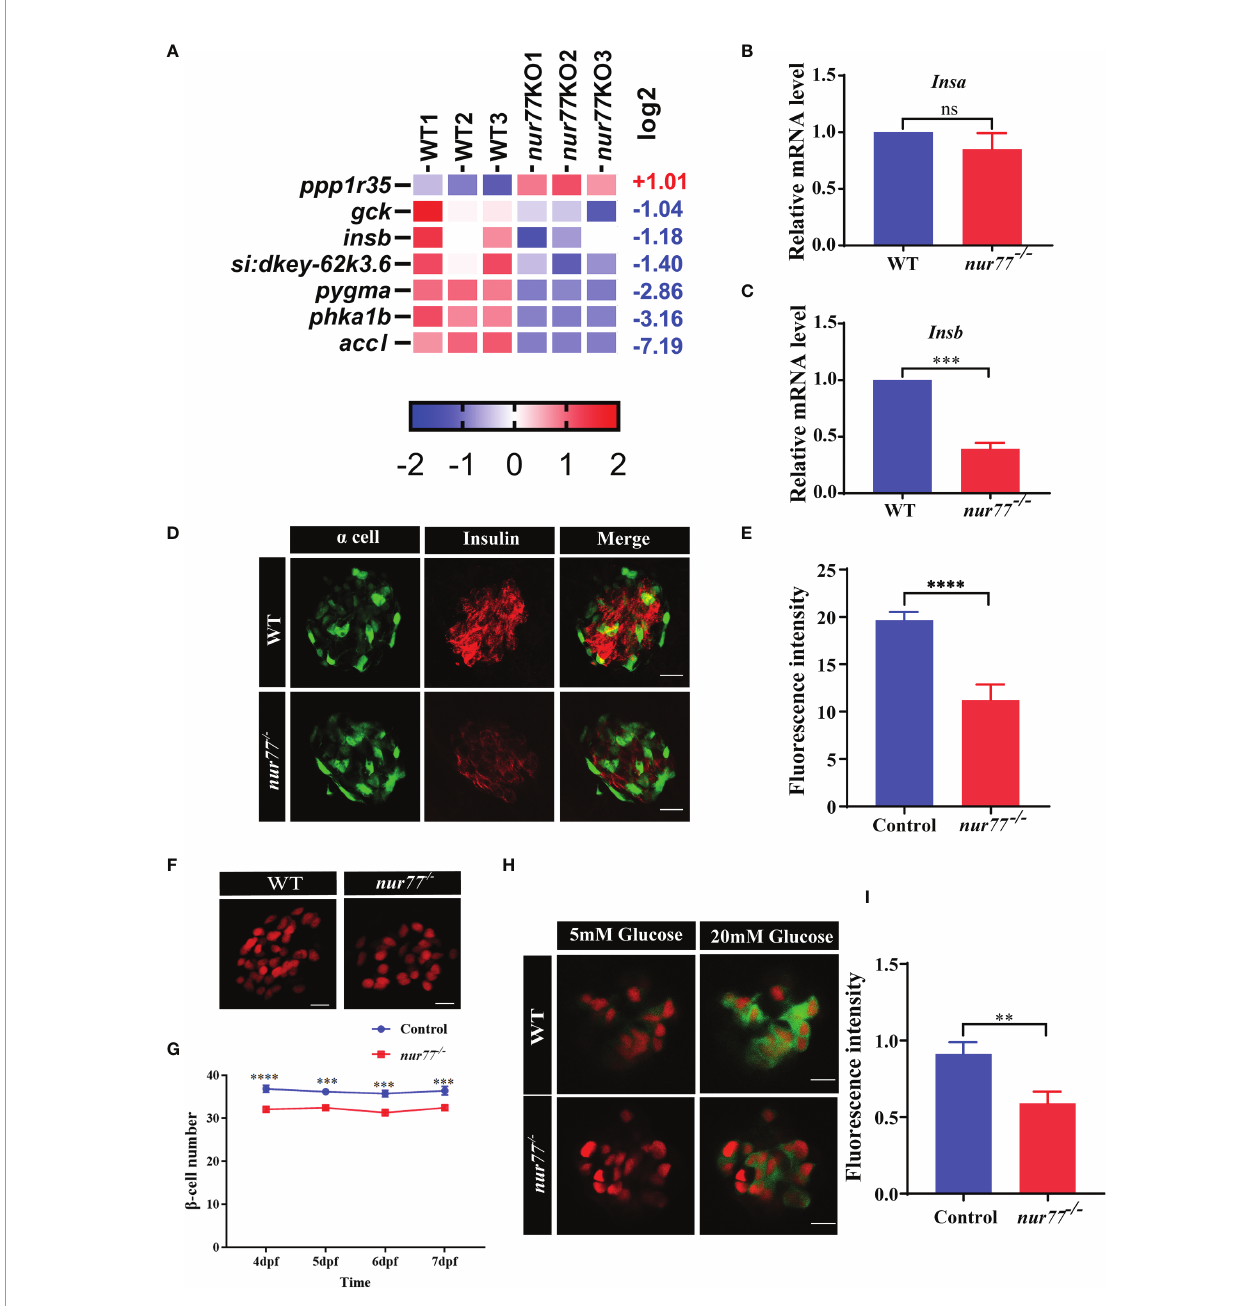
FIGURE 6 | Nur77 regulates insulin secretion and b -cell number in zebra fi sh larvae. (A) Heatmaps of transcripts in insulin signaling pathway. Colors represent high (red), low (blue), or average (white) expression values based on Z-score-normalized fragments per kilobase per million mapped read (FPKM) values for each gene. (B, C) The validation of the expression levels of insulin genes by qRT-PCR analysis in WT and nur77 − / − zebra fi sh larvae, (B) insa ( n = 3), (C) and insb ( n = 3). (D, E) The insulin contents in WT and nur77 − / − zebra fi sh larvae. (D) Representative images of the fl uorescence of a cell and b cell from control and nur77 − / − ; a cells are indicated by the green fl uorescence with Tg(gcg:eGFP) , b cell are indicated with red fl uorescence by immunostaining with insulin antibody. (E) Quanti fi cation of b -cell fl uorescence intensity from control and nur77 − / − . The number of larvae ( n = 12~18). (F, G) The number of pancreatic b cells in Tg(Ins:H2BmCherry) and nur77 − / − ;Tg (Ins:H2BmCherry) zebra fi sh larvae. (F) Representative images of the b -cell (red) number in Tg(Ins:H2BmCherry) and nur77 − / − ;Tg(Ins:H2BmCherry) at 6 dpf. (G) Quanti fi cation of b -cell number in Tg(Ins:H2BmCherry) and nur77 − / − ;Tg(Ins:H2BmCherry) from 4 to 7 dpf zebra fi sh larvae ( n = 19~50). (H, I) The glucose- stimulated GCaMP6s response in b cells of Tg(Ins:H2BmCherry);Tg(Ins:GCaMP6s) and nur77 − / − ;Tg(Ins:H2BmCherry);Tg(Ins:GCaMP6s) . (H) Representative images of GCaMP6s response in b cells of Tg(Ins:H2BmCherry);Tg(Ins:GCaMP6s) and nur77 − / − ;Tg(Ins:H2BmCherry);Tg(Ins:GCaMP6s) by 5 or 20 mM glucose ECS solution; green signal is GCaMP6. (I) Quanti fi cation of GCaMP6s response (GFP fl uorescence intensity) in b cells of Tg(Ins:H2BmCherry);Tg(Ins:GCaMP6s) and nur77 − / − ;Tg(Ins:H2BmCherry);Tg(Ins:GCaMP6s) . Results are represented as means with standard errors ( n = 13~20); ns, no signi fi cance; ** p < 0.01, *** p < 0.001, **** p < 0.0001 by t